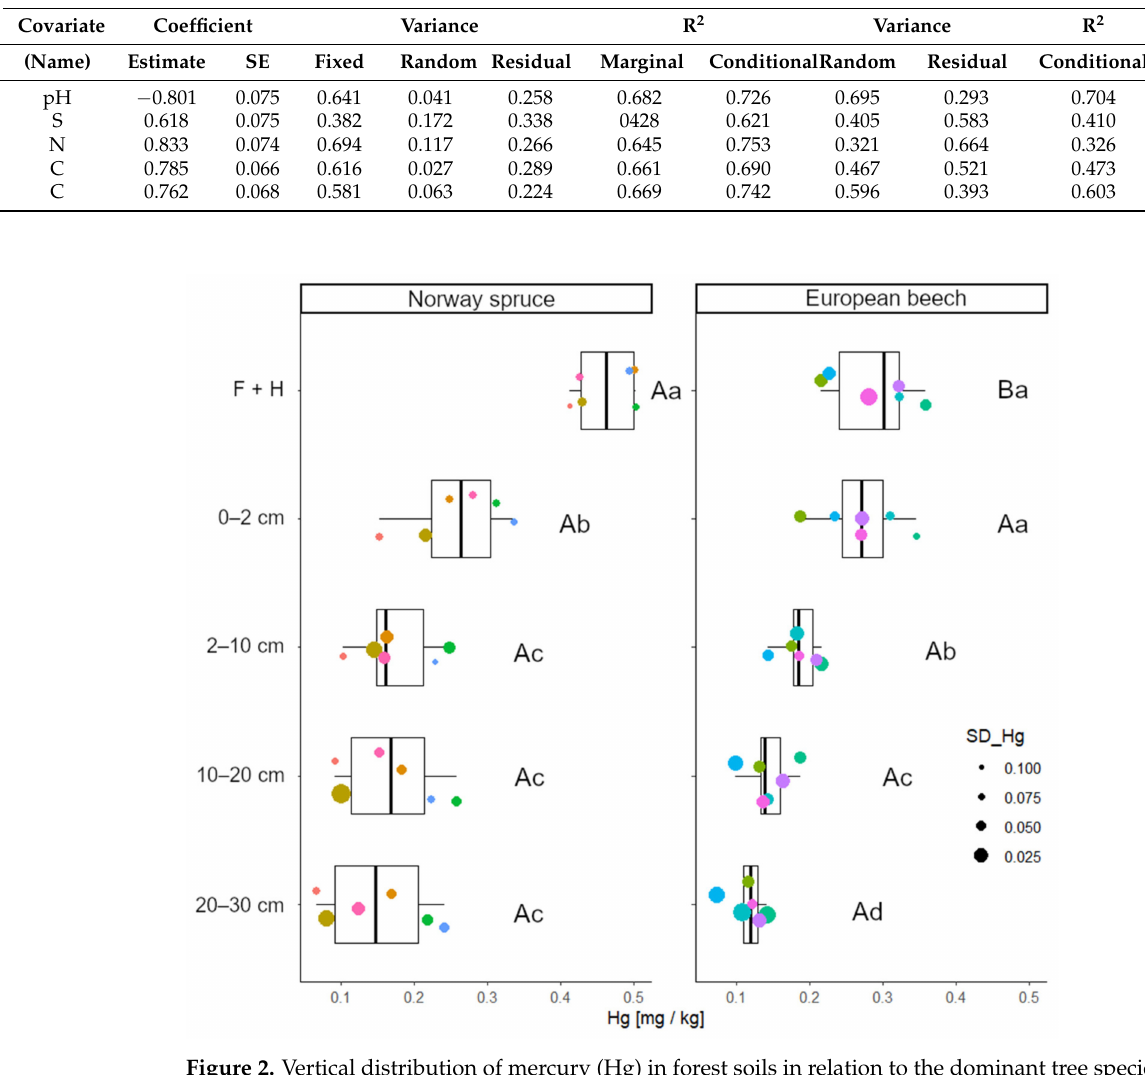
Figure 2. Vertical distribution of mercury (Hg) in forest soils in relation to the dominant tree species; different uppercase letters indicate significant differences between forest types (likelihood ratio test); different lowercase letters indicate significant differences between sampling depths within a particular forest type (Tukey’s test); boxes represent quartiles; points represent mean values at a particular site (differentiated by colors); the within-site variation is indicated by standard deviation (SD) that is inversely related to point